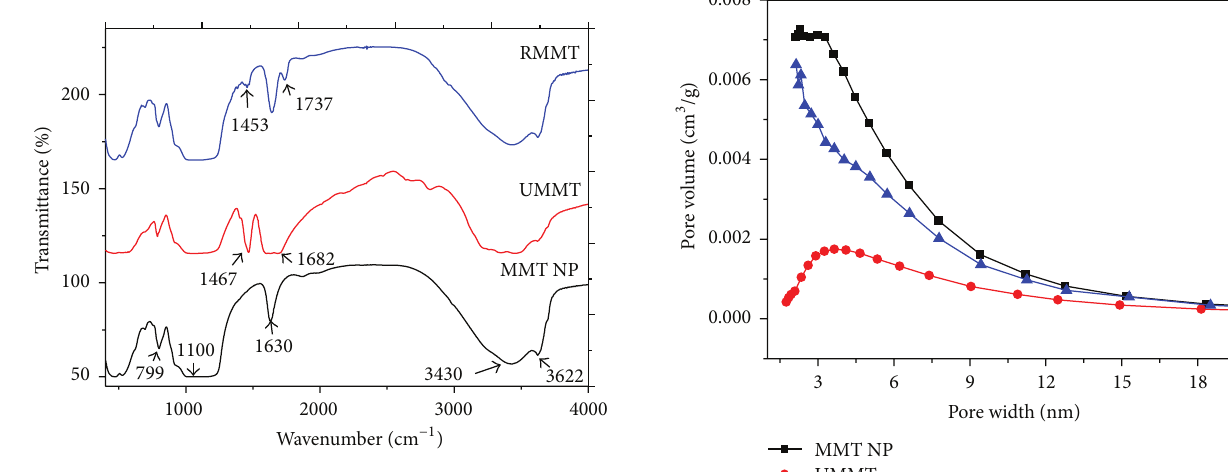
Figure 5: FT-IR spectra of MMT NP, UMMT, and RMMT.